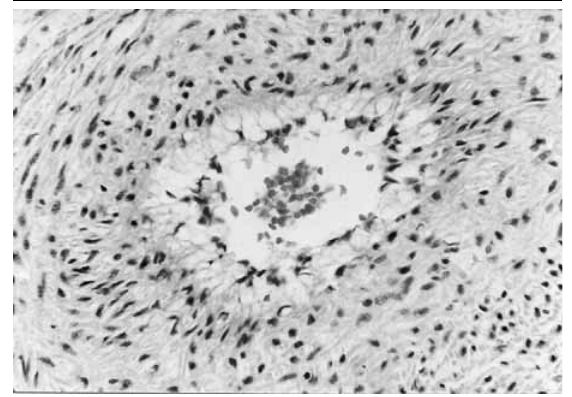
figurE 2 – Microscopy (HE): arteriopathy – wall thickening with edema, hyperplasia of the middle layer and lumen reduction . 40 × / 0.65 HE: hematoxylin and eosin.